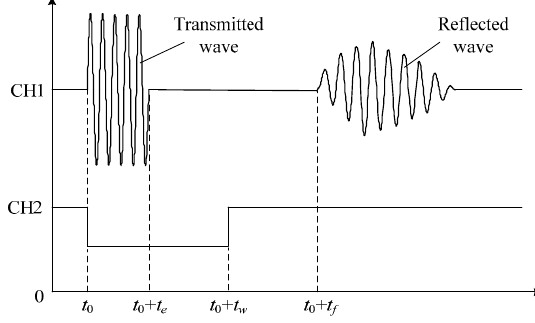
Figure 4. Sketch of transmitted and reflected waves.